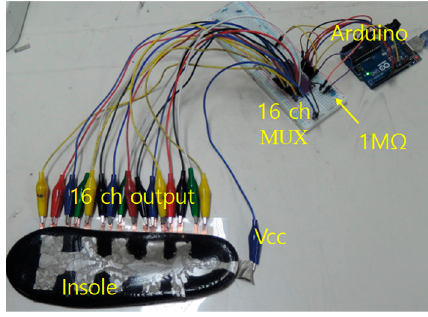
Figure 9. Measurement configuration of the smart insole using Arduino and 16 ‐ channel multiplexer.